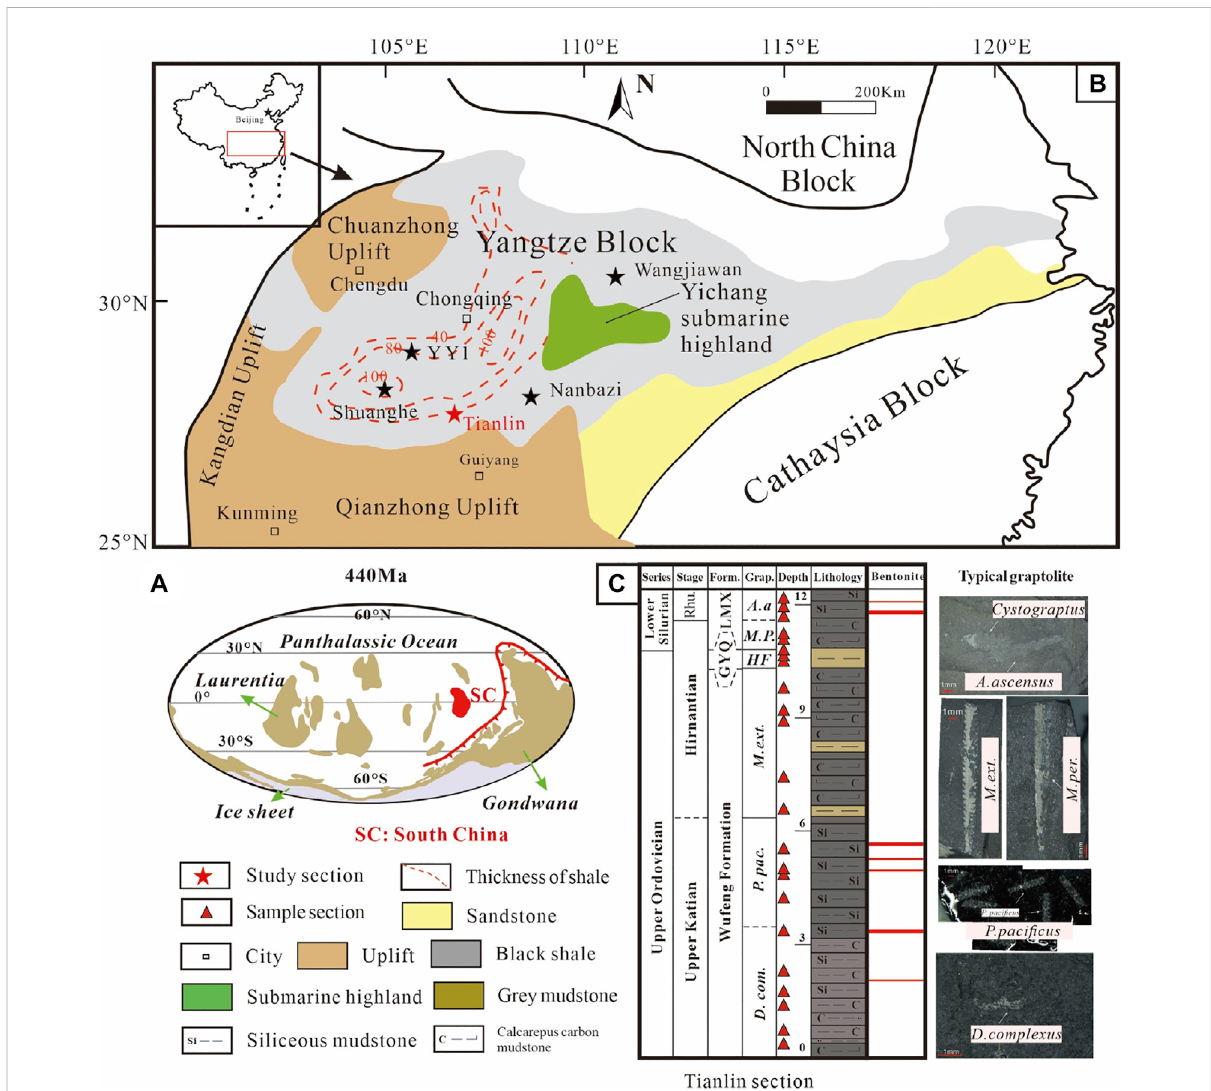
FIGURE 1 PaleogeographiccontextandgeologicalsettingoftheTianlinsection. (A) GlobalpaleogeographyfortheLateOrdovician(~445 Ma)(Zhouetal., 2015). (B) Paleogeography of the Upper Yangtze Basin from the Late Ordovician to Early Silurian (modi fi ed from Liu et al., 2016) (C) Biostratigraphy and bentonite distribution for the Tianlin section (graptolite biozones based on Chen et al. (2004). GYQ, Guanyinqiao Formation; HF , Hirnantia Fauna